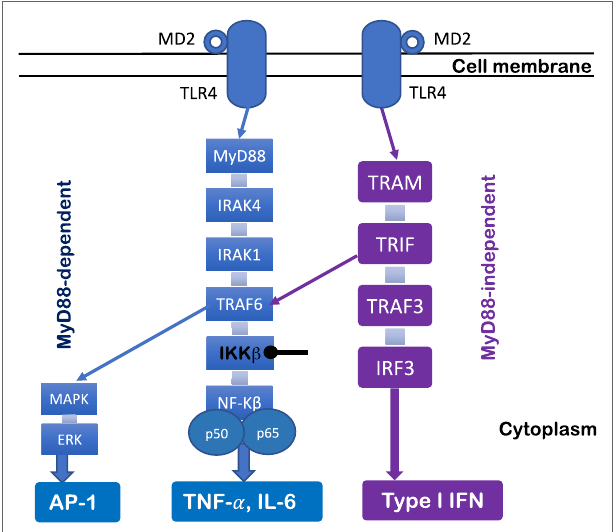
FigURe 1 | Toll-like receptor (TLR) 4 signaling pathway. TLR4 signaling pathway can be regulated by MyD88-dependent and MyD88-independent pathways. Upon the activation of MyD88, IL-1 receptor-associated kinase (IRAK) and tumor necrosis factor-receptor-associated factor 6 (TRAF6) are recruited to lead to degradation of IKK β and disinhibition of NF- κ B, which results in pro-inflammatory cytokine production (e.g., TNF- α and IL-6). The MyD88 pathway signals also activate MAKP and extracellular signal-regulated kinase (ERK) through TRAF6, which results in AP-1 activation. The MyD88-independent pathway is TRIF dependent. Upon the activation of TRIF-related adaptor molecule (TRAM)/TRIF, TRAFs are recruited, which leads to interferon regulatory factor 3 (IRF3) activation and type I IFN production.